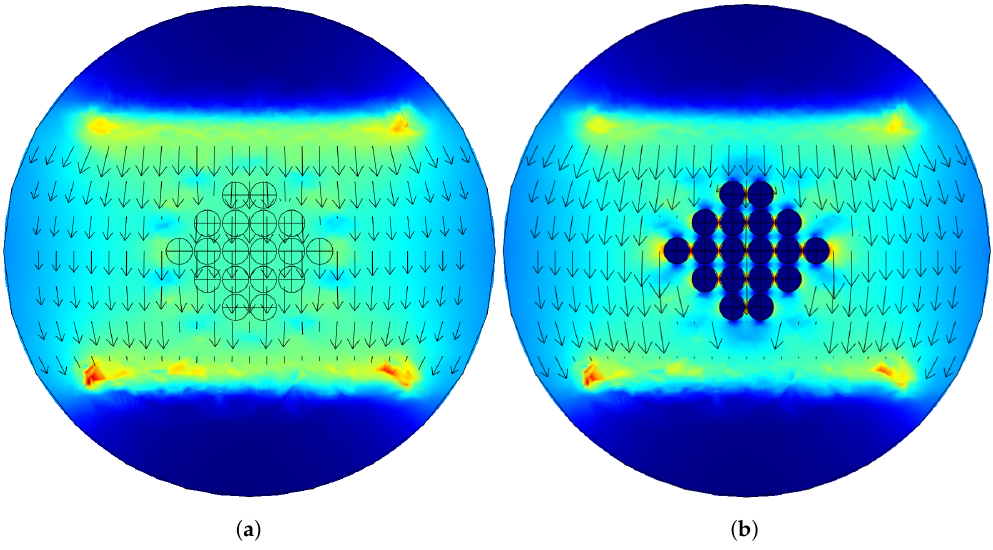
Figure 4. Current density vector simulated with Comsol Multiphysics; arrows represent the current density direction and the surface color represents the magnitude. ( a ) When all the spheres are supposed to be water, ( b ) when all the spheres are supposed to be